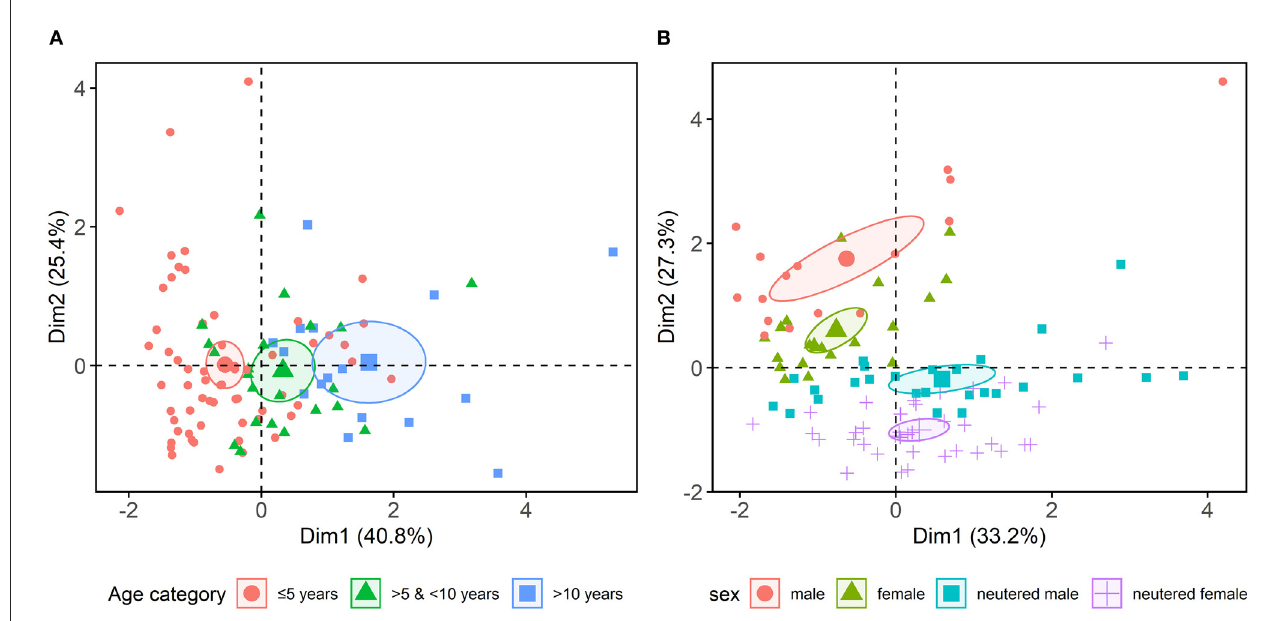
FIGURE1 Combined principal component analysis, focussing on age, sex, neutering and the three most significant neurotransmitter variables (norepinephrine, dopamine, γ -aminobutyric acid/glutamate ratio) revealed (A) age- and (B) age sex/neuter-dependent clusters, indicating a hormonal influence on urinary neurotransmitters